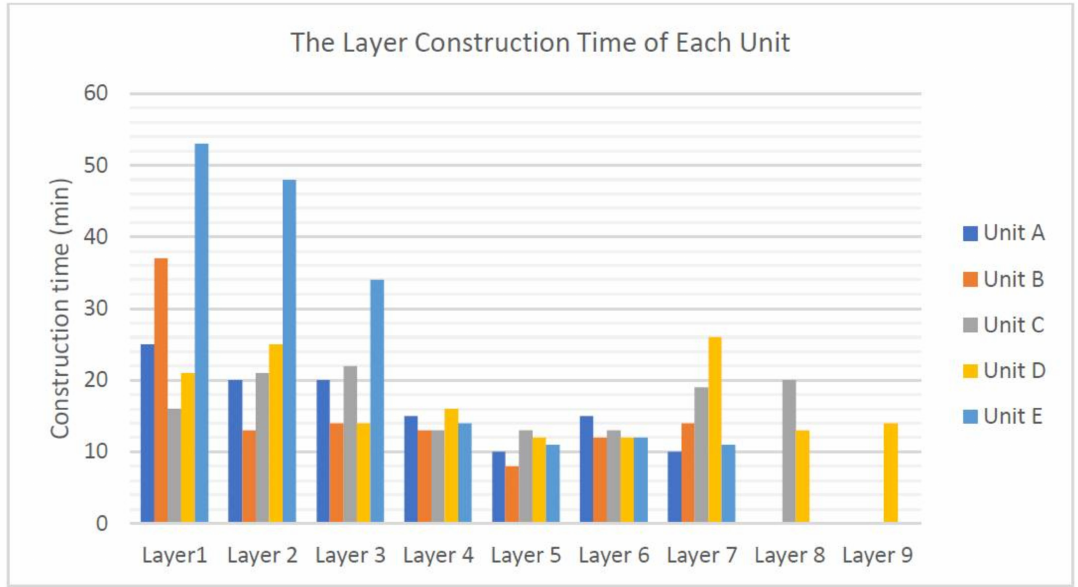
Figure 11. The layer construction time of each unit by manual